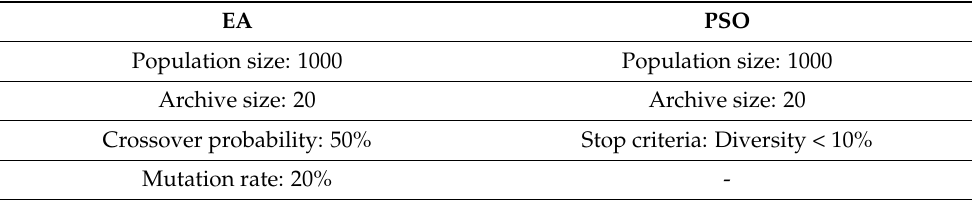
Table 3. User-defined constants in EA and PSO.